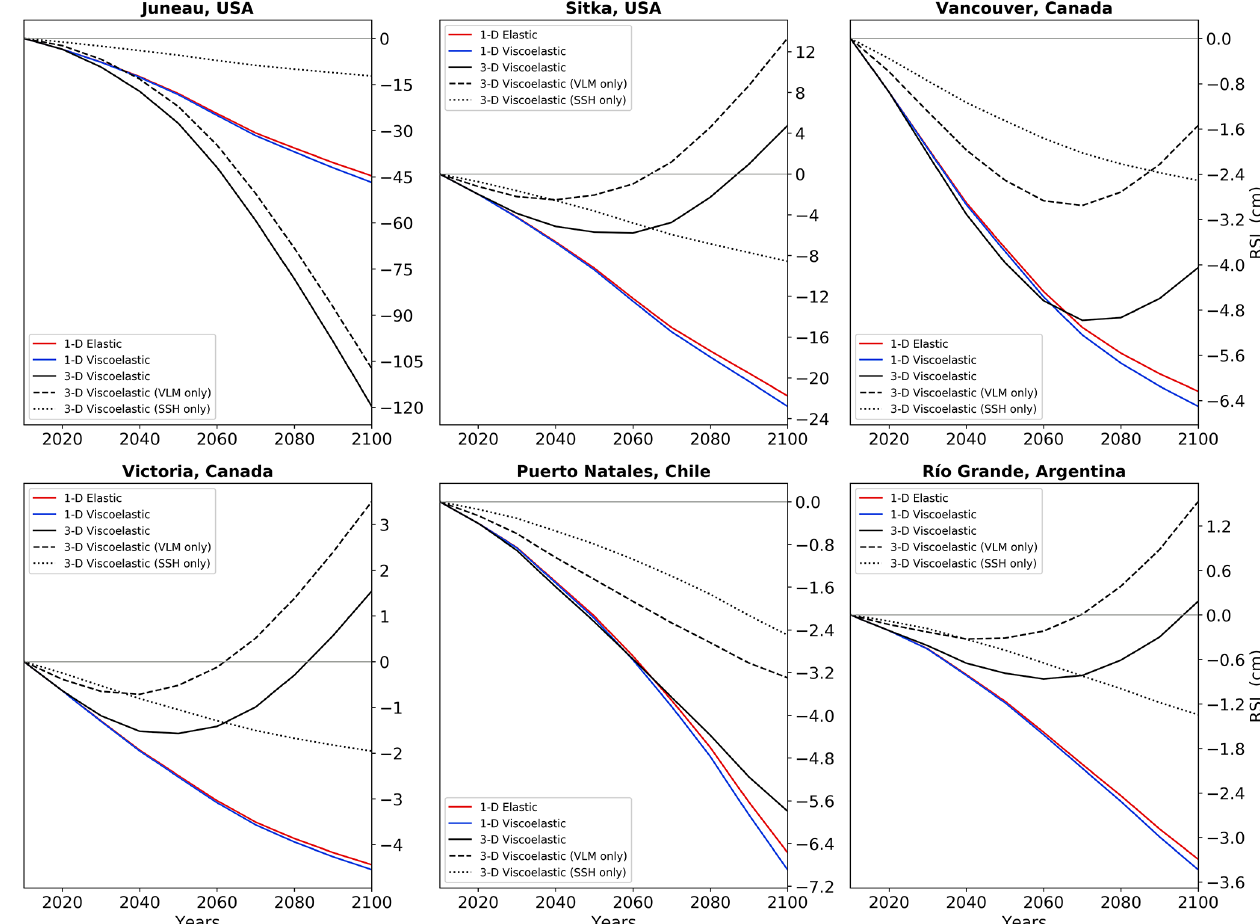
Figure 5. Calculated RSL curves showing the time variation of the spatial patterns in Fig. 4 at the locations indicated in Figs. 1 and 4. The results for a 1D viscoelastic model using our reference global viscosity profile (Sect. 2.2) are also included. The contributions of vertical land motion (VLM) and sea-surface height (SSH) change to RSL are also shown for the 3D viscoelastic Earth model. As for Fig. 4, these results do not include the sea-level signal associated with ice mass changes from outside the respective RGI